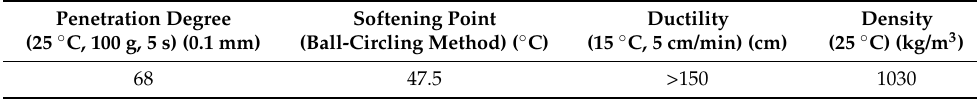
Table 1. Quality indices of Zhonghai AH-70 heavy-duty road asphalt.